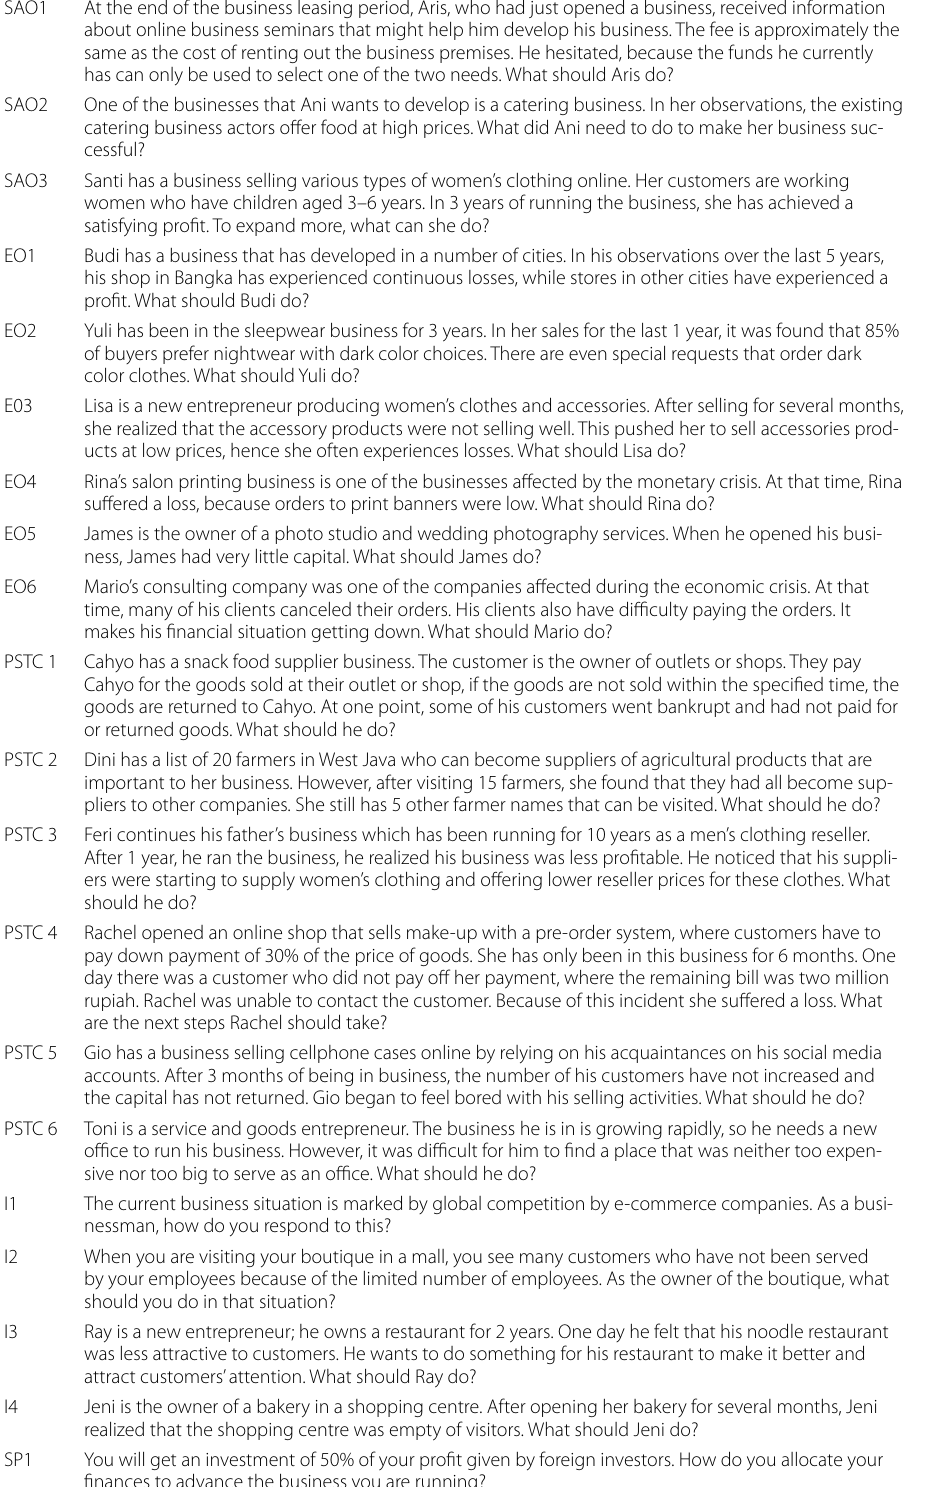
Table 4 Final cases in entrepreneurial competencies inventory